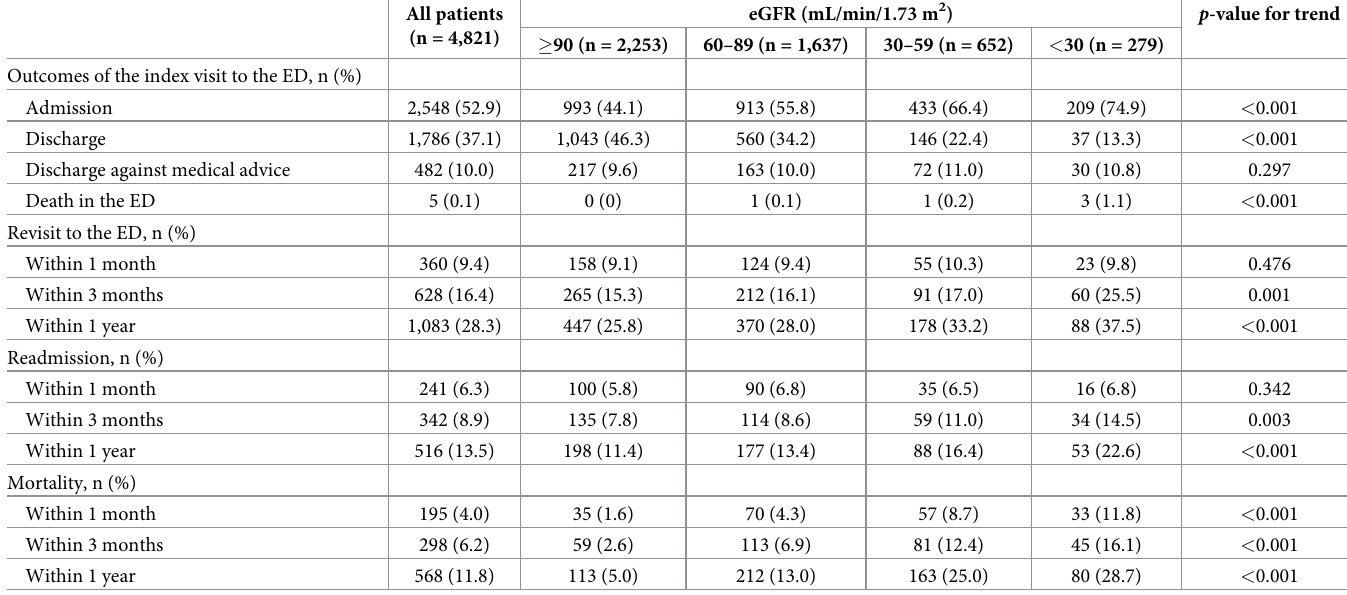
Table 2. Outcomes during the index visit to the ED and